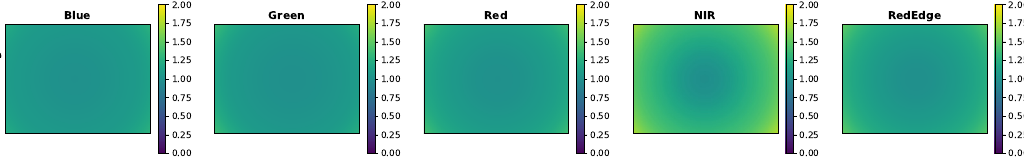
Figure 12. Example raw RedEdge imagery taken of the integrating sphere during calibration testing.